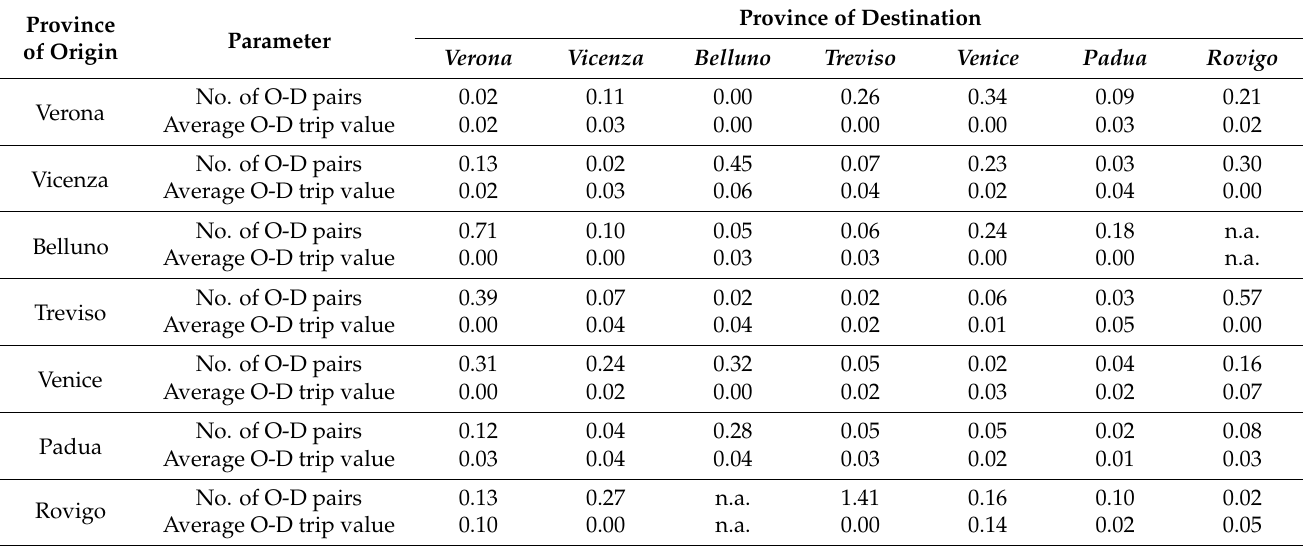
Table 5. Coefficients of variation on O-D pairs of trips for the five survey days.